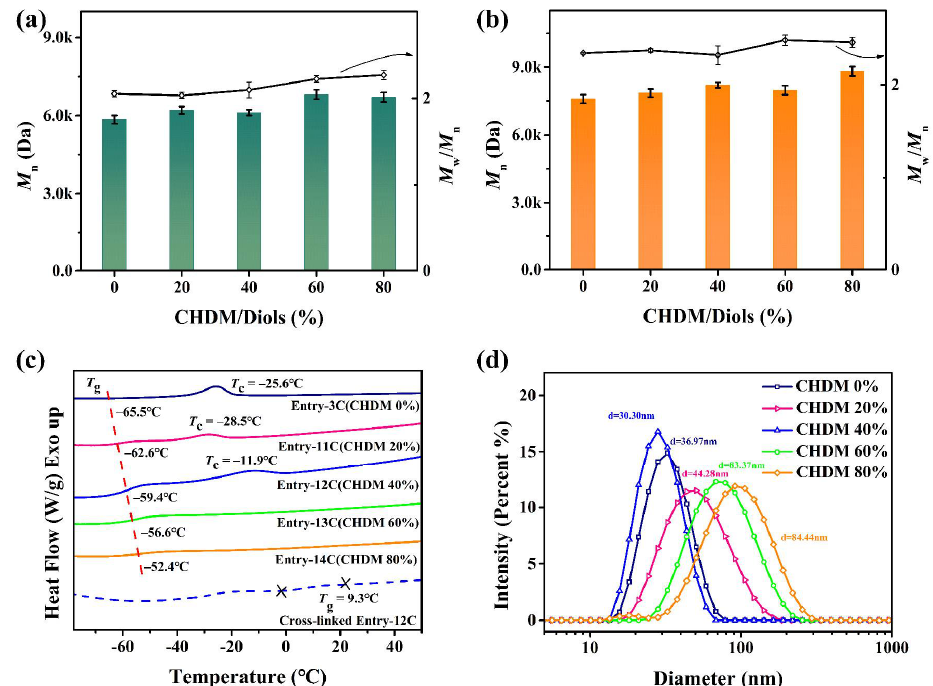
15 16 Figure 5. Molecular weight and polydispersity for linear polyester ( a ) and comb-like polyester ( b ),